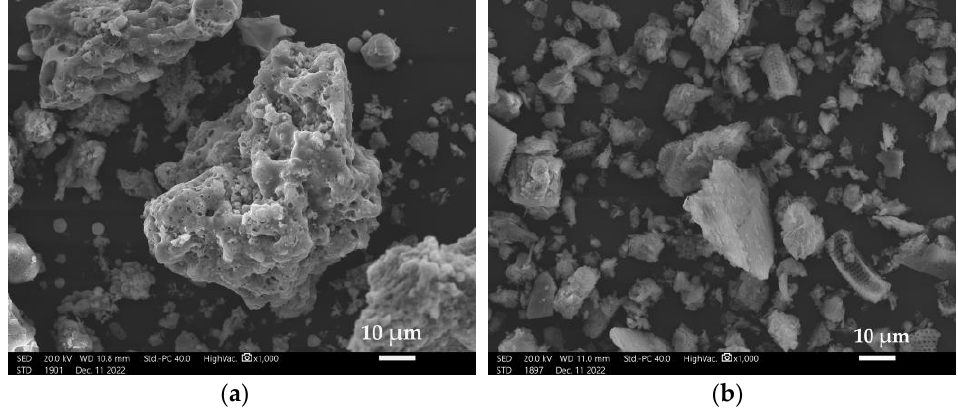
Figure 1. Particle morphology: ( a ) Belchatow fly ash (1000× magnification), ( b ) diatomite dust (1000× magnification). Table 2. Composition of geopolymer samples based on fly ash from Belchatow, sand, and diatomite dust (non-calcined (DN) and calcined